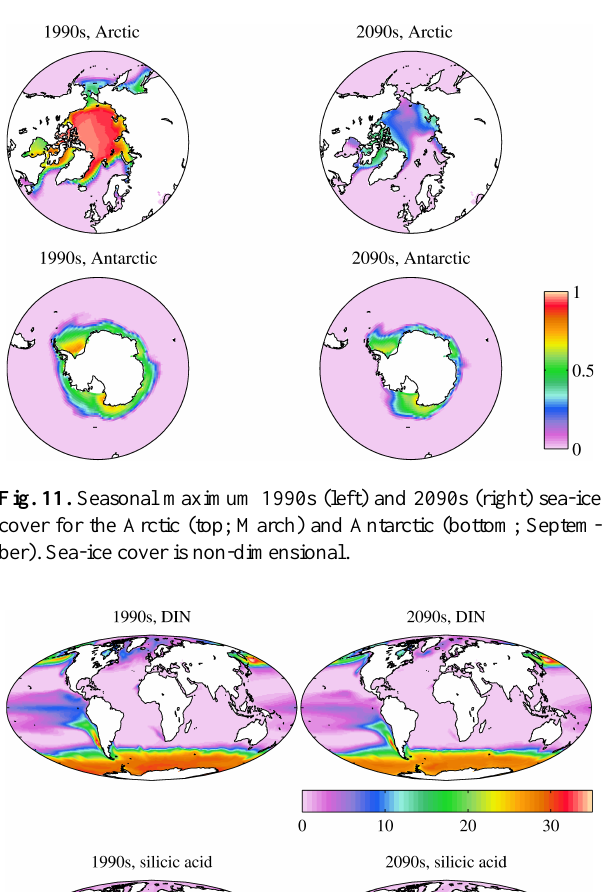
− 1.7 % (upper 100 m changes are, respectively, − 8.7 % and − 1.5